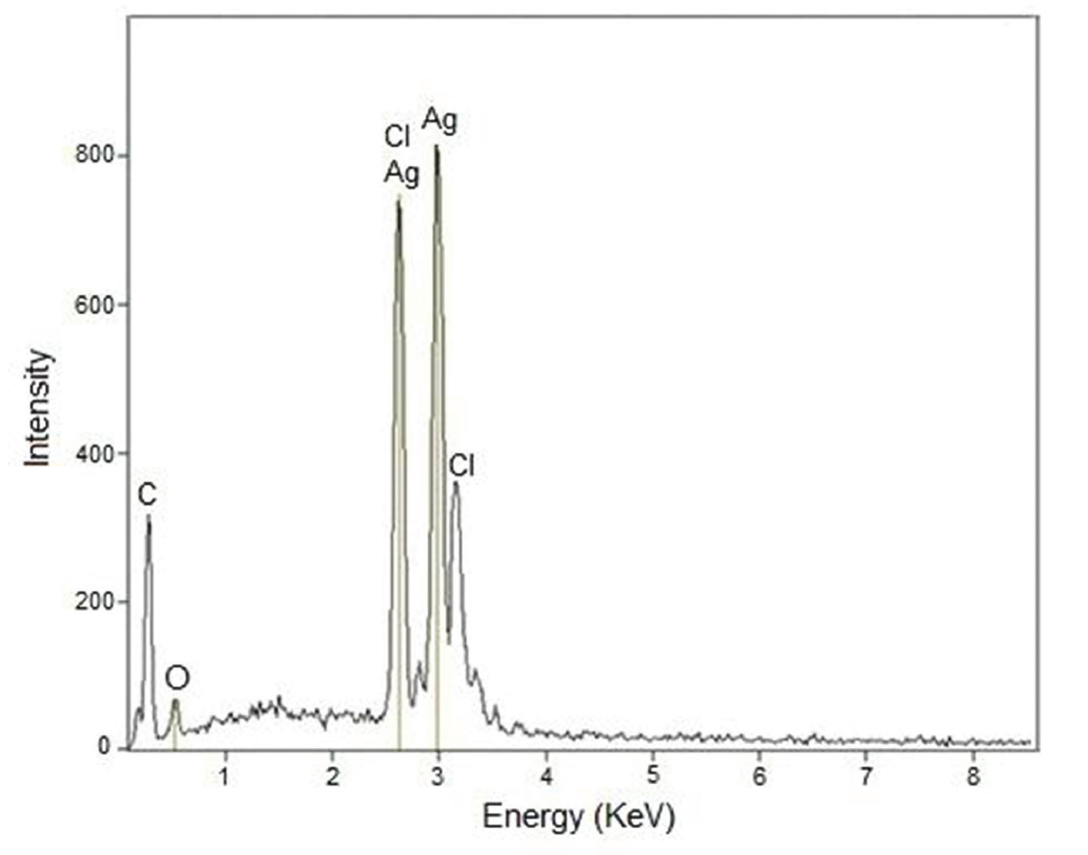
Figure 7: EDX spectrum of green synthesized nanoparticles.